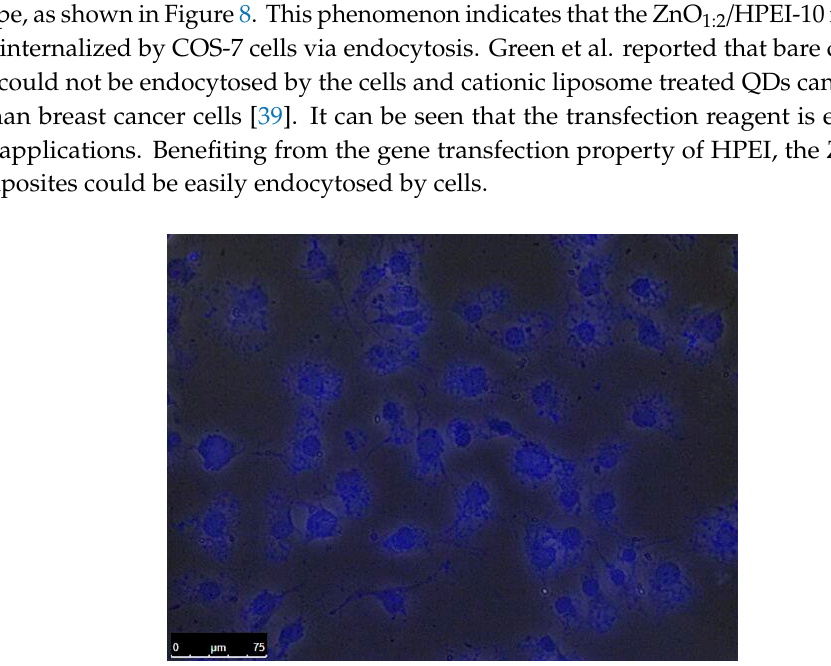
Figure 8. Fluorescence micrograph of COS-7 cells incubated with PBS solution of ZnO 1:2 /HPEI-10 nanocomposites.